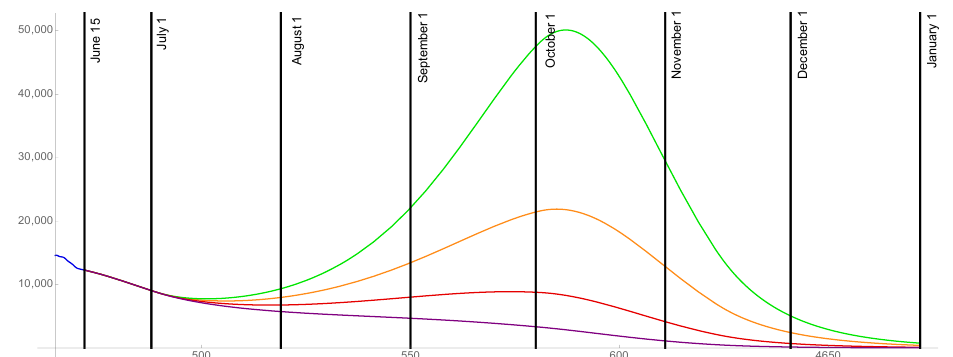
Figure 7. Model outcomes for the daily reported cases DR ( t ) , for the level of social distancing resumption ω = 0.03 (green), ω = 0.025 (orange), ω = 0.02 (red), ω = 0.015 (purple).